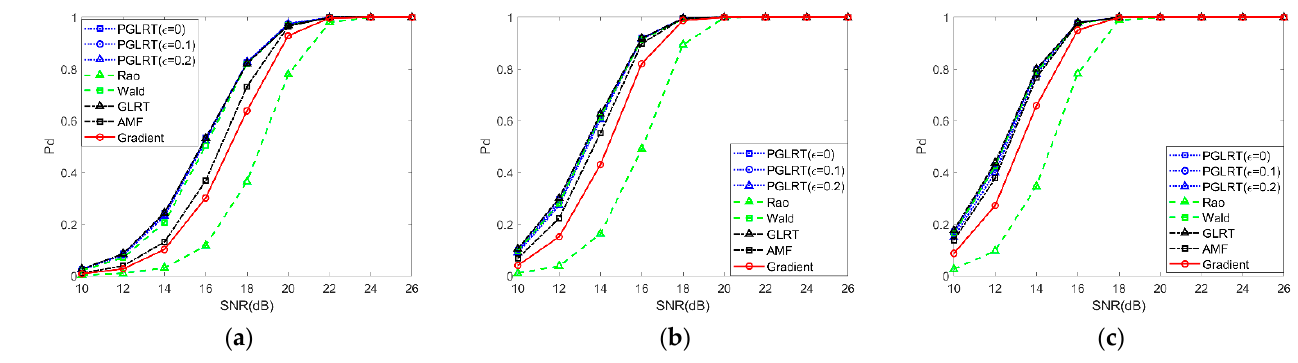
Figure 6. P versus SNR for Figure 6. P d versus SNR for N = 16, cos 2 θ = 1: ( a ) K = 24; ( b ) K = 32; ( c ) K = 40. d